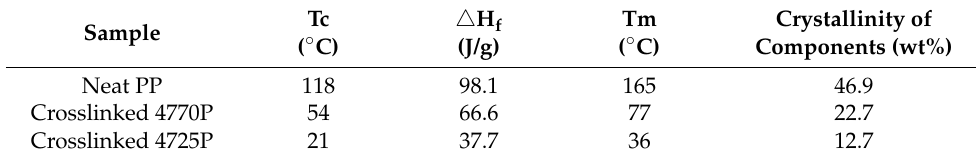
Table 3. Crystallization temperatures, enthalpies of fusion, crystallinities, and melting points of neat PP and crosslinked EPDMs.